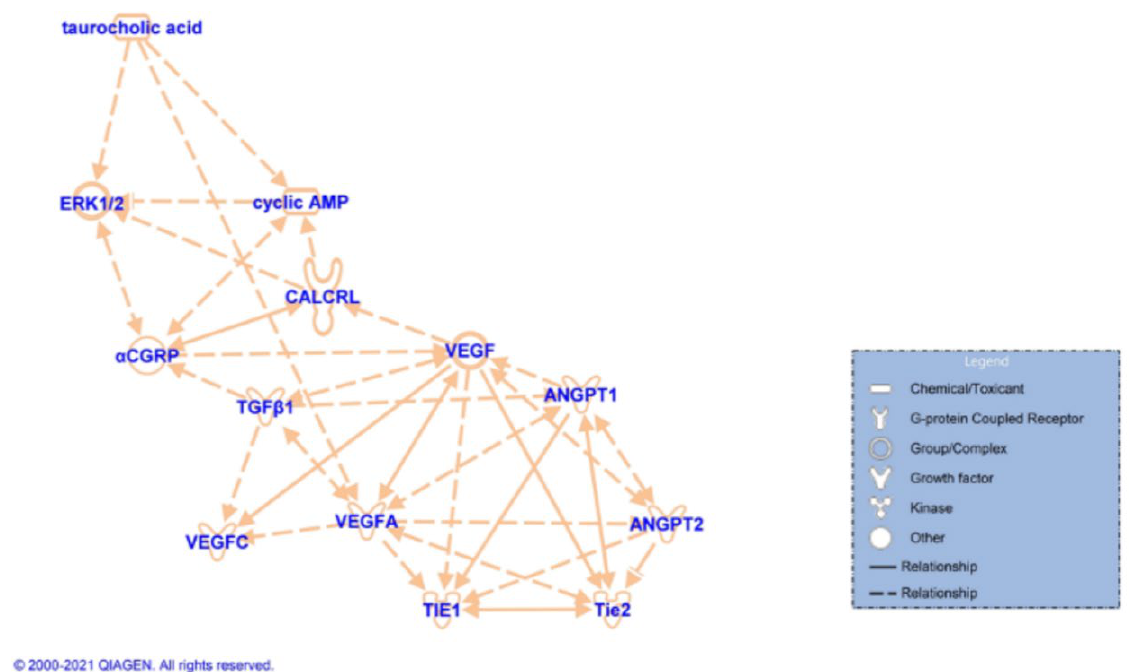
Figure 6. Ingenuity Pathway Analysis (IPA) shows the relationship between TC and α - CGRP/CALCRL axis and TGF- β 1 signaling leading to increase liver angiogenesis by cAMP/ERK signaling-dependent pathways.